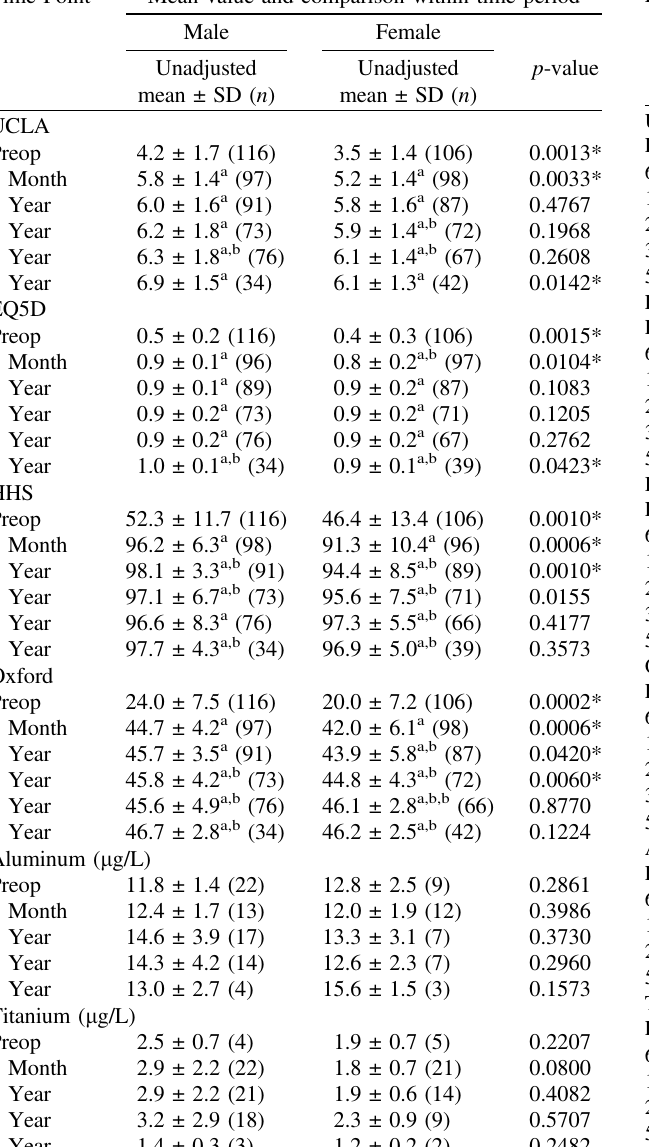
Table 4. Subgroup analysis by age; difference between time point was performed with Bonferroni adjusted p -value. Follow up